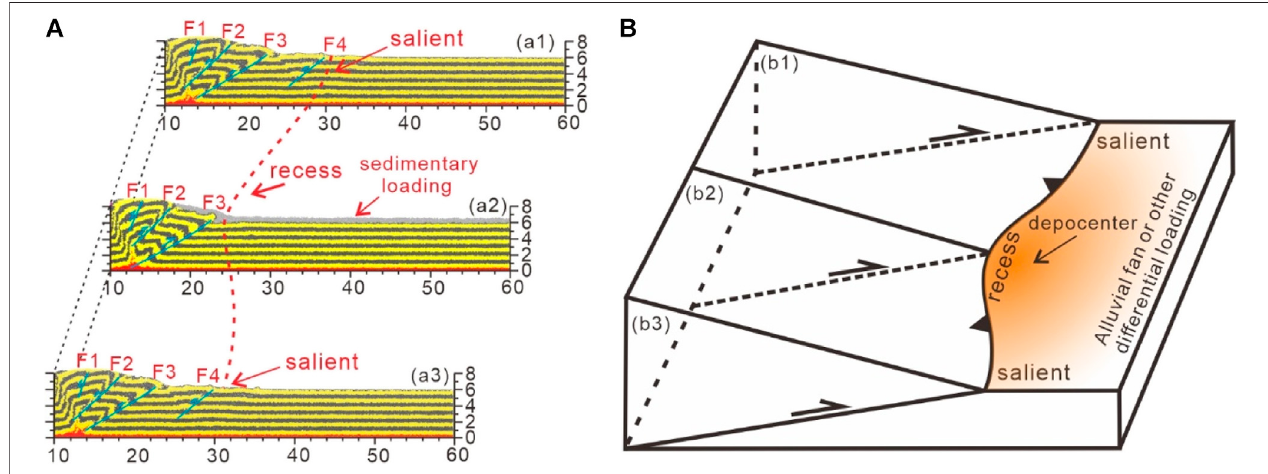
FIGURE13| TheDEMresultsinthispaper (A) andtheconceptualmodelmodi fi edfromLiuetal.,2020 (B) presenttheoccurrenceofrecessand salientinthefront of thrust wedges.